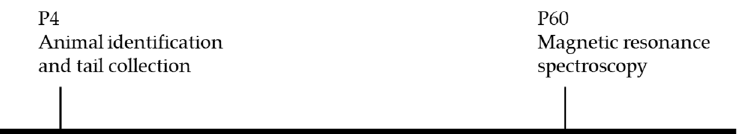
Figure 6. Timeline of resonance spectroscopy experiments in this study. Animals were identified on postnatal day (P)4 with permanent tattoos on toes and tails were collected for genotyping. All animals and went through localized 1 H-MRS on P60.